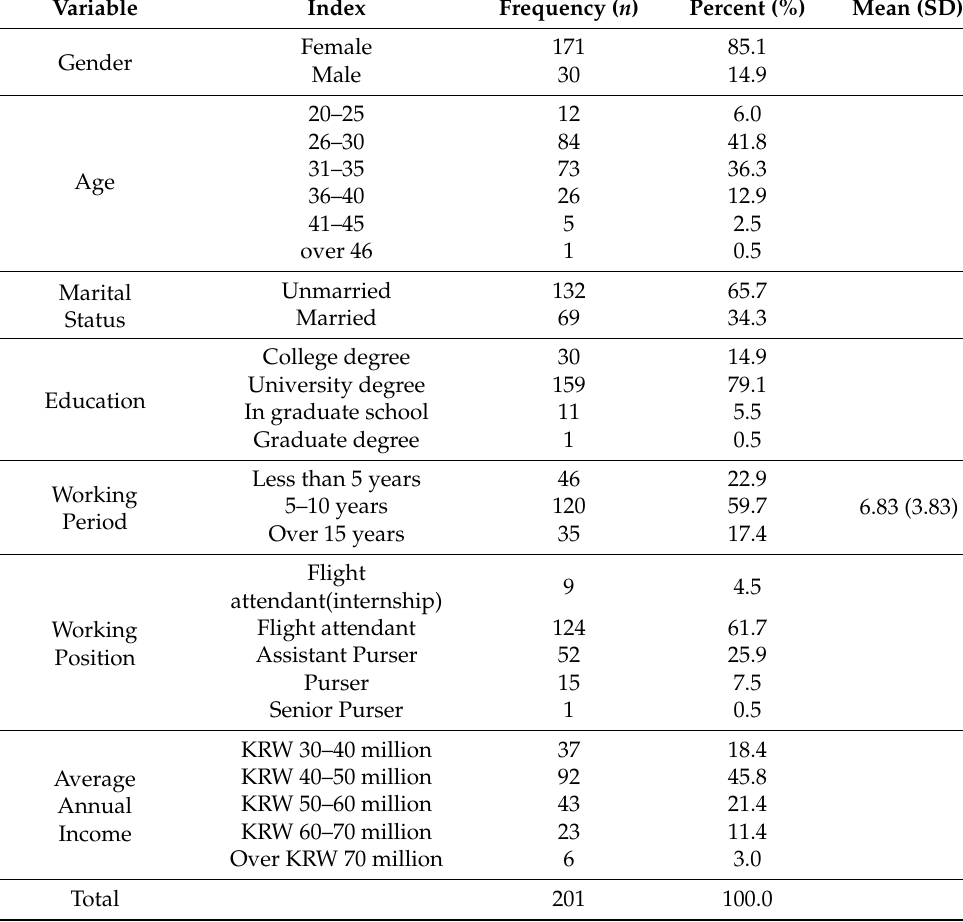
Table 1. Demographic characteristics of